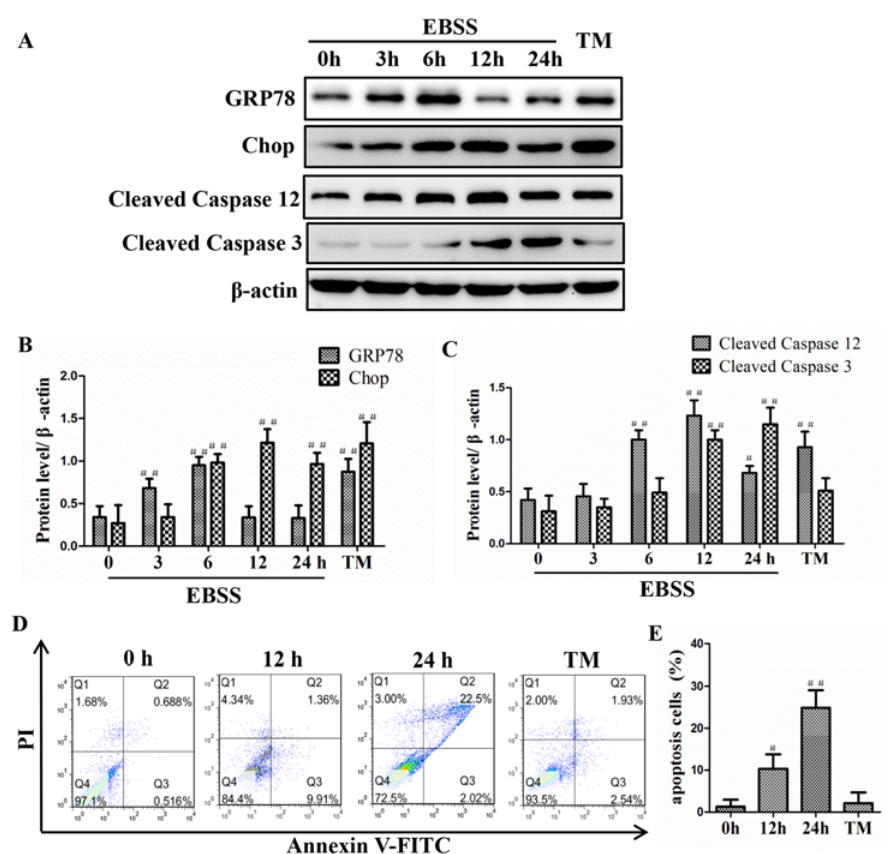
Figure 3. EBSS induced ER stress and apoptosis in ARPE-19 cells in a time-dependent manner. ( A – C ) The ER stress-related proteins and the ER stress-associated downstream apoptotic protein caspase-3 (a mitochondrial apoptotic marker) were examined by Western blot; ( D , E ) The percentage of apoptotic cells was determined based on a flow cytometric analysis. The data are presented as the means ± SD of three independent experiments. TM stands for tunicamycin. # p < 0.05, ## p < 0.01 compared with control (0 h).